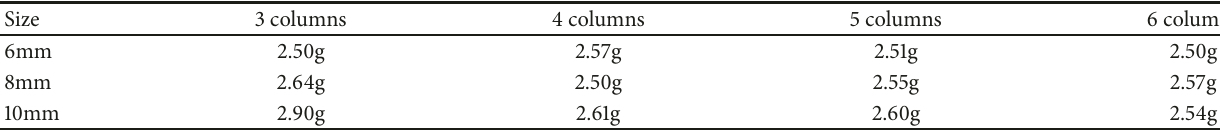
Table 2: Mass parameters of hemispheric convex models.